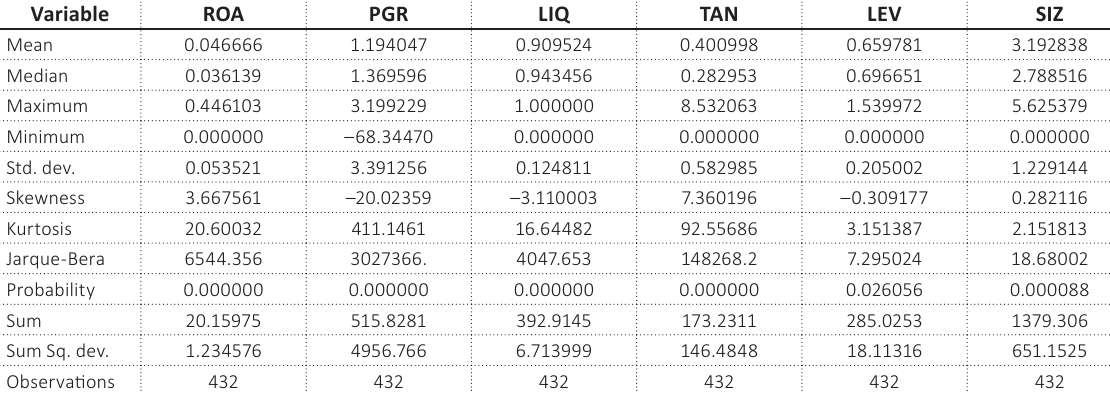
Table 2. Variables’ descriptive statistics